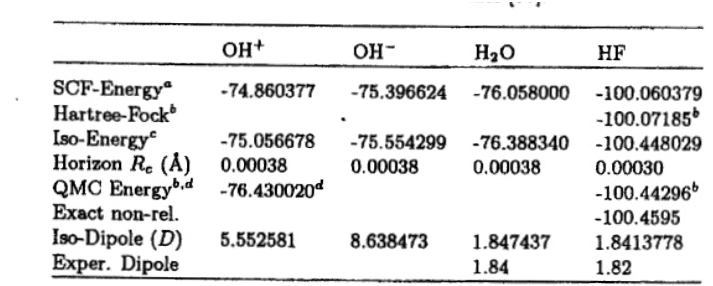
Figure 23: A reproduction of Table 5.1. of Ref. [53] presenting the first exact represen- tation of the experimental data of the water molecule, including its electric and magnetic moments, via isomathematics and isochemistry, by therefore providing a second experi- mental confirmation of the validity in molecular structures of Einstein’s determinism ac- cording to Lemma II-3.7, with a convergence of the isoperturbative series at least one thousand time faster than conventional series, thus providing an experimental confirma- tion of Corollary